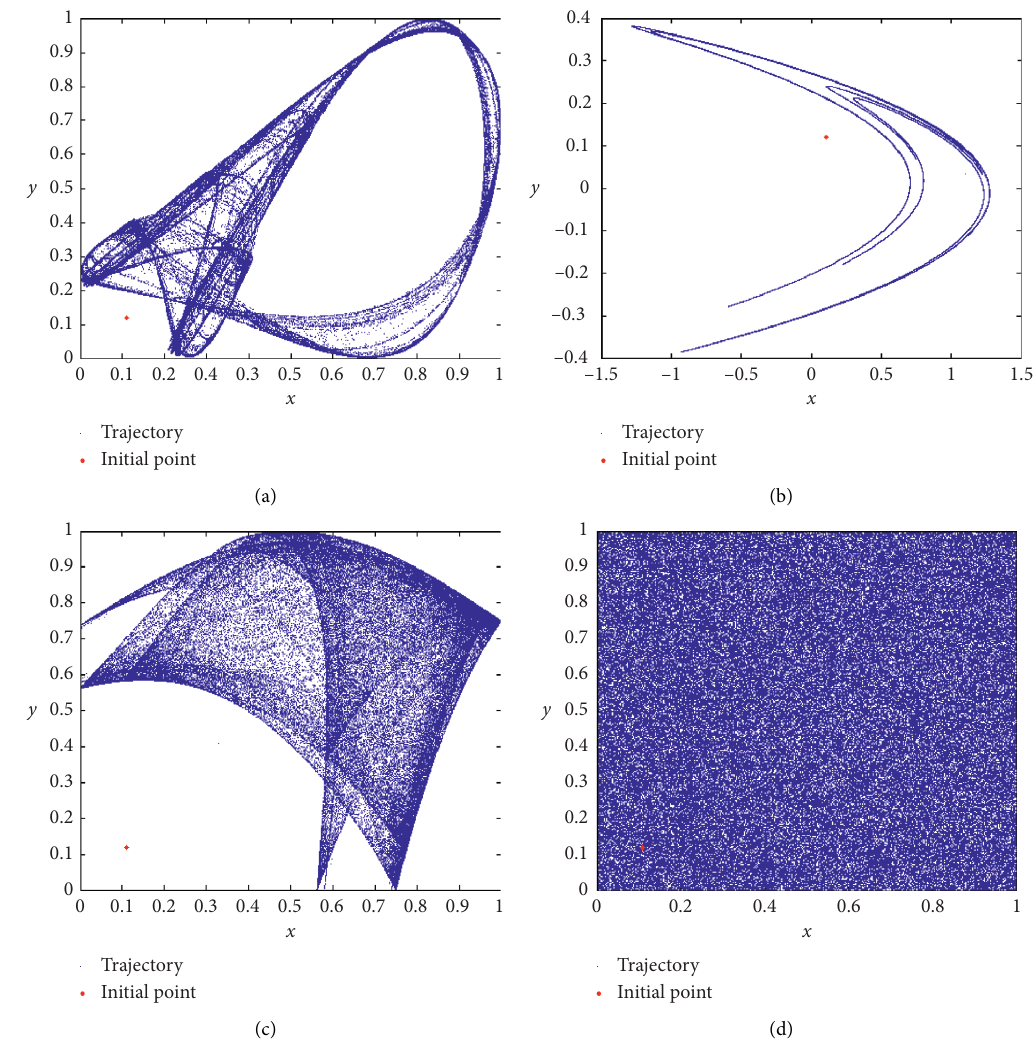
Figure 5: Phase portrait of chaotic attractor in 2D chaotic (a) logistic map, (b) Henon map, (c) SLMM map, and (d) proposed hyperchaotic